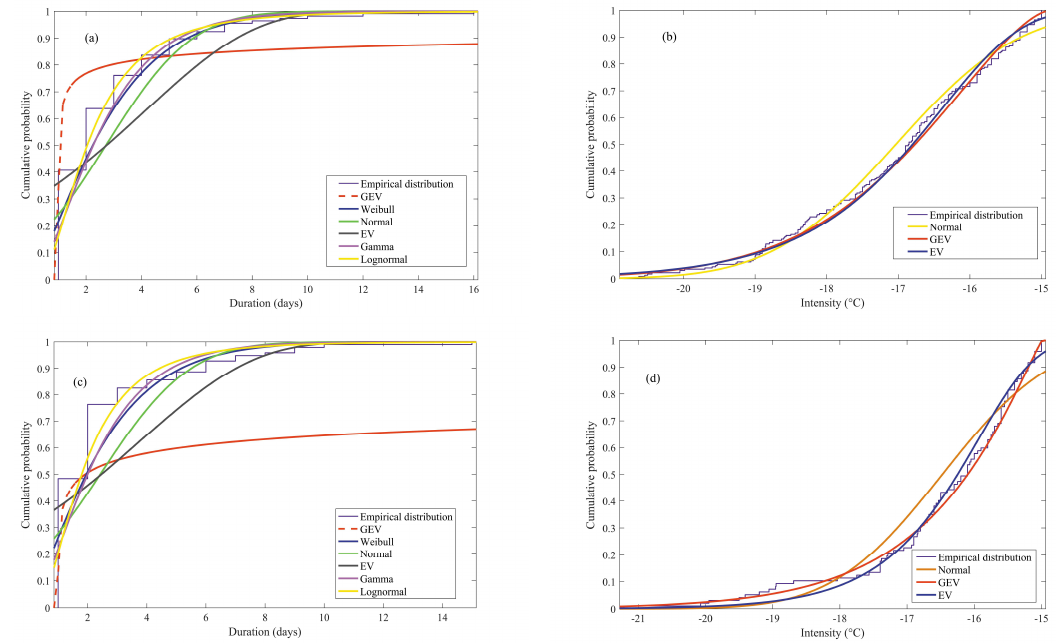
Figure 7. Marginal distributions of extreme low temperature event duration ( a , c ) and intensity ( b , d ) at Yanqing station for study periods: 1978–1998 ( a , b ) and 1999–2015 ( c , d ). Table 8. Parameter estimation and root-mean-square error (RMSE) for selected copula distributions for 20 meteorological stations in